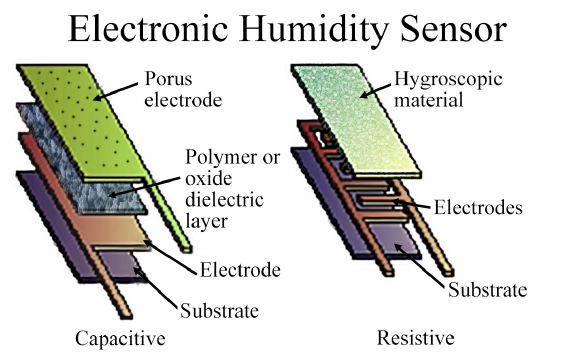
Figure 4. Design comparison of resistive- and capacitive-type humidity sensors.